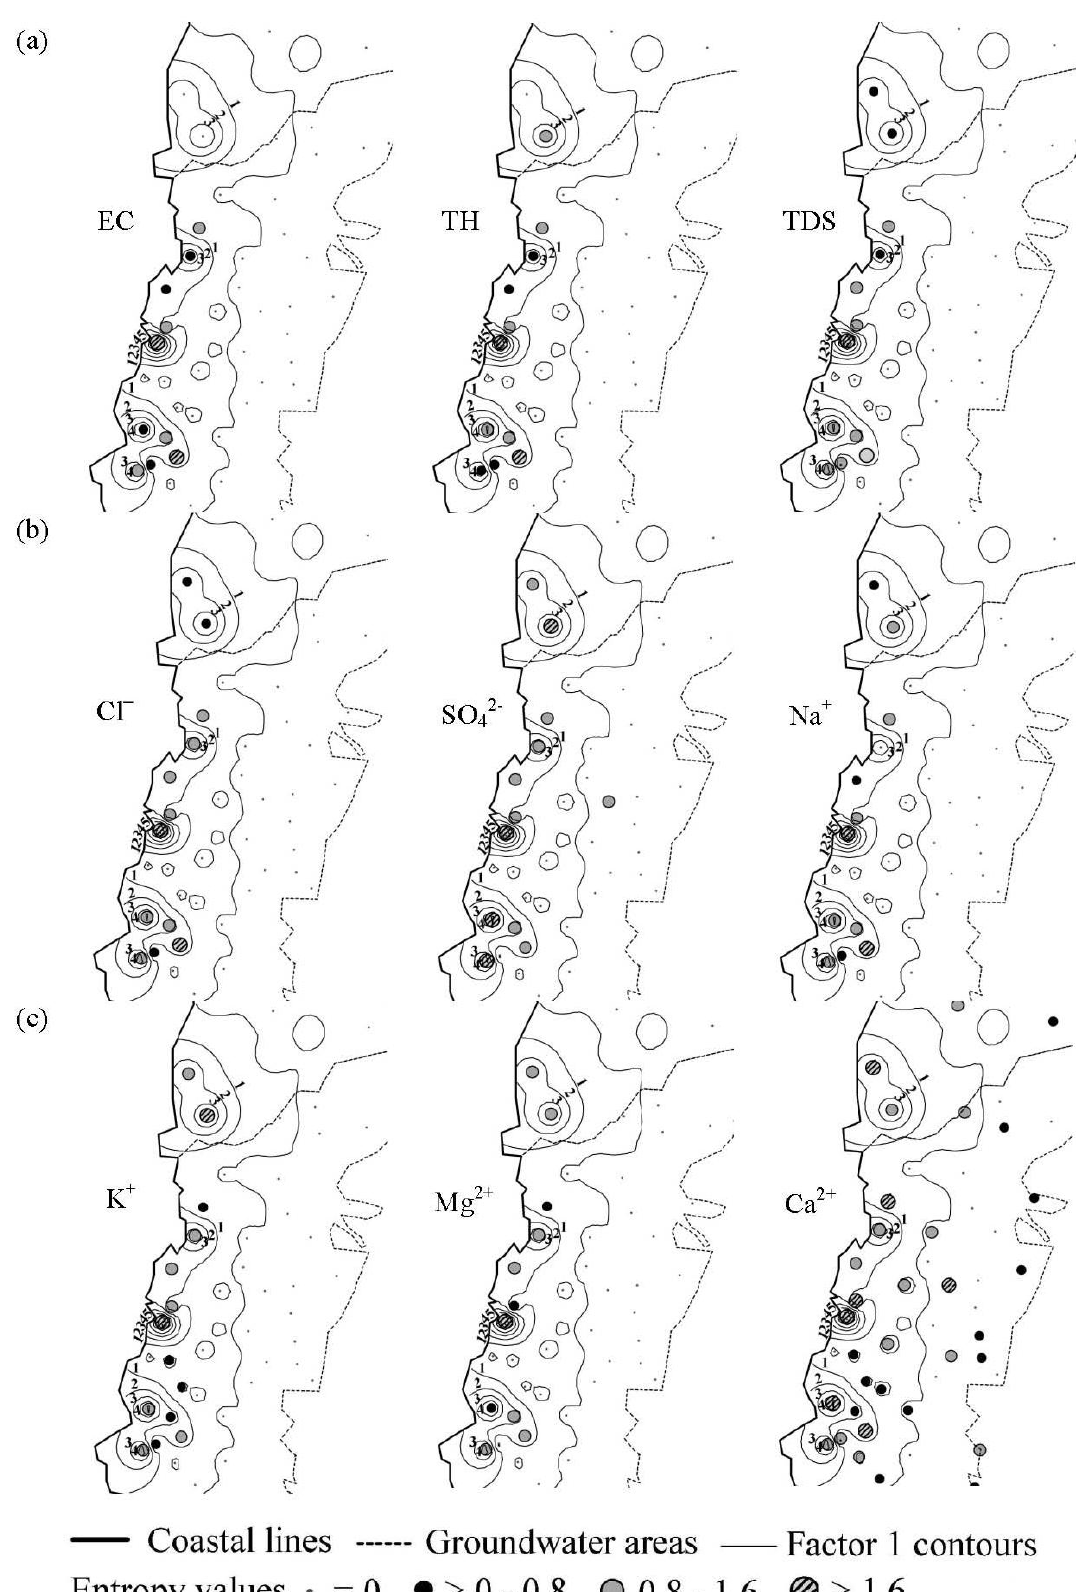
Figure 5. (a) ~ (c) Distribution of the information entropy values for various hydrochemical parameters in common Factor 1; (d) ranks of information entropy values Factor 1 in Southwestern